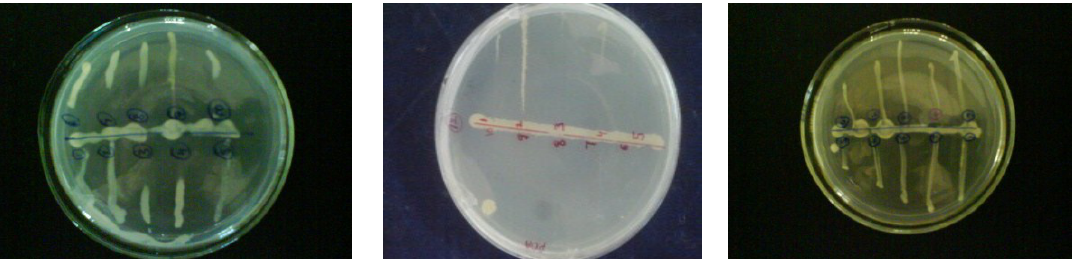
Figure 2. Primary screening (cross streaking) results of isolates.